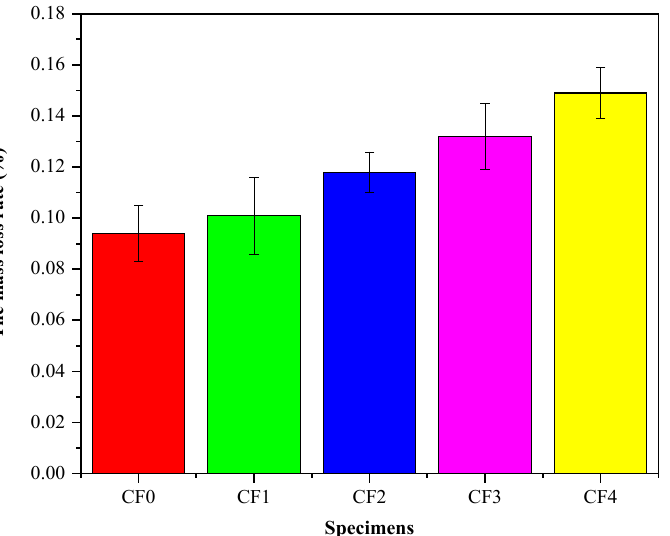
Figure 7. The mass loss rate of CSM with 100% RMA under different fly ash replacement